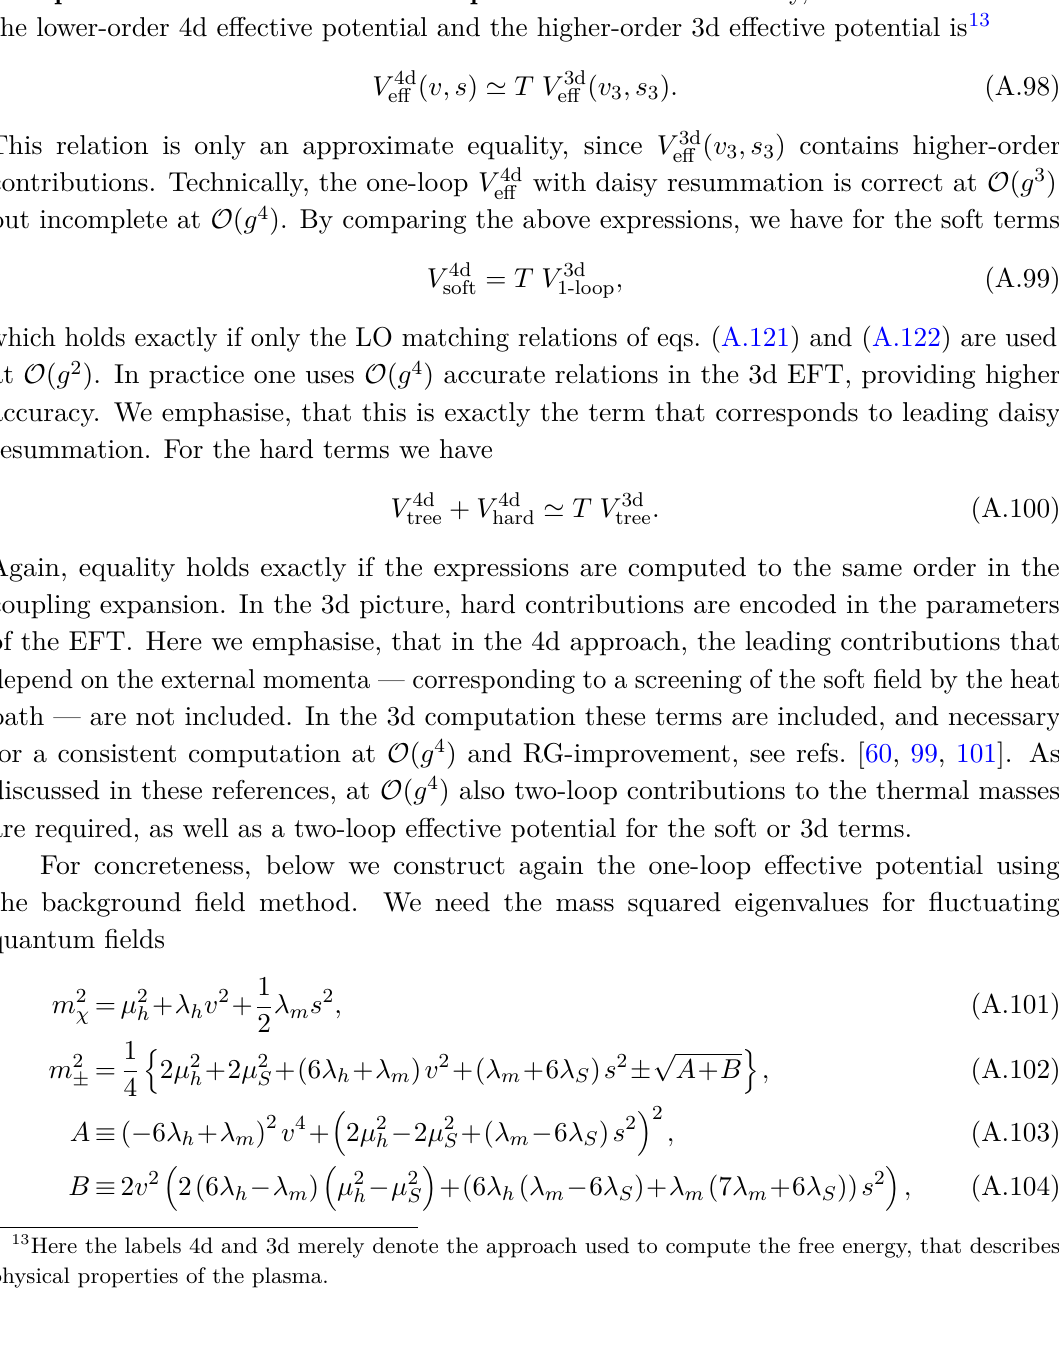
figure 10: (a) two-loop corrections to the mass, (b) one-loop corrections to couplings and (c) one-loop resummation of the fields, from momentum dependent contributions to the 2-point function. The inclusion of all these contributions is systematic in the EFT language, and they are resummed to all-orders in dimensional reduction to 3d EFT, in analogy to daisy resummation that resums one-loop thermal mass to all